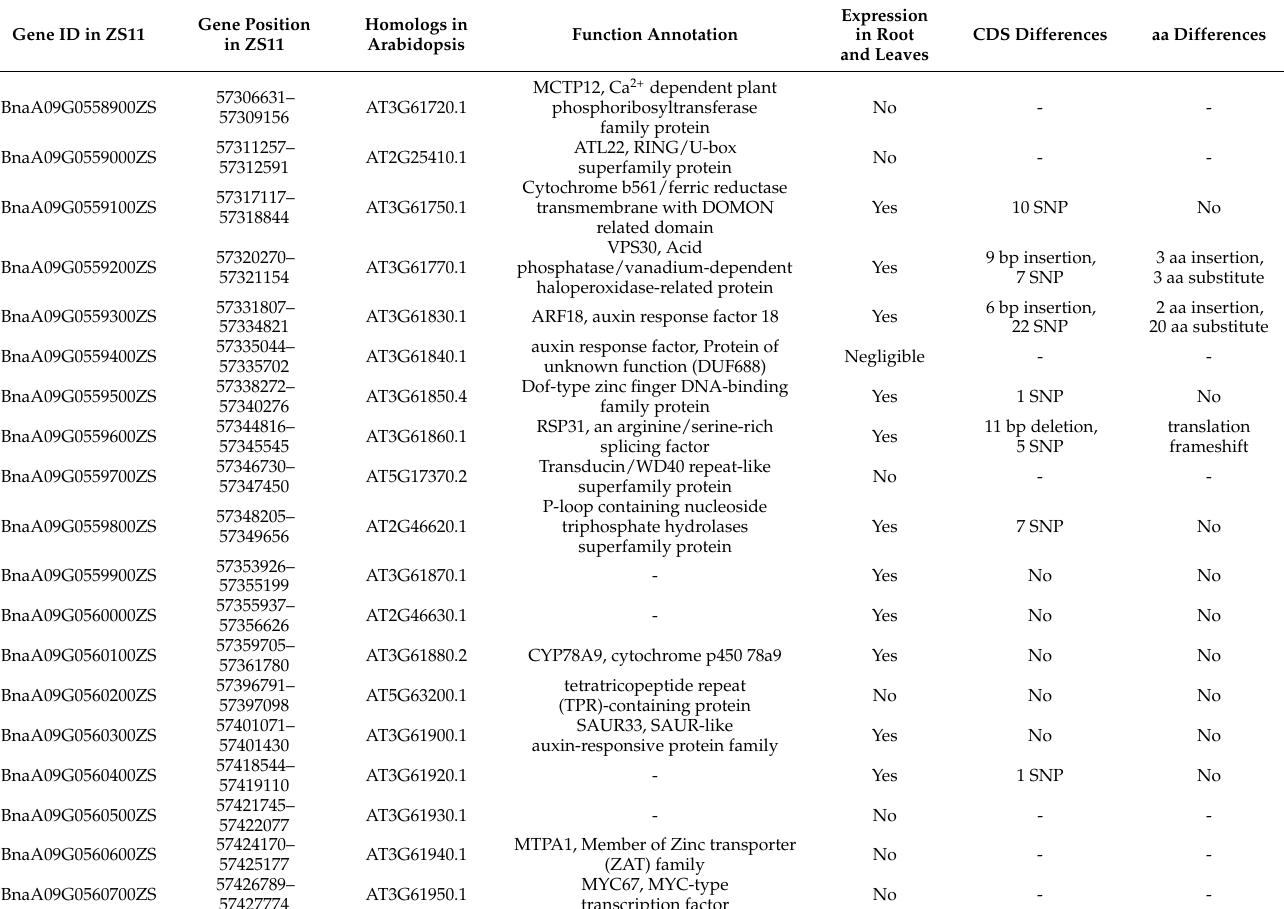
Table 3. Information on the candidate genes in the target region of RT.A09